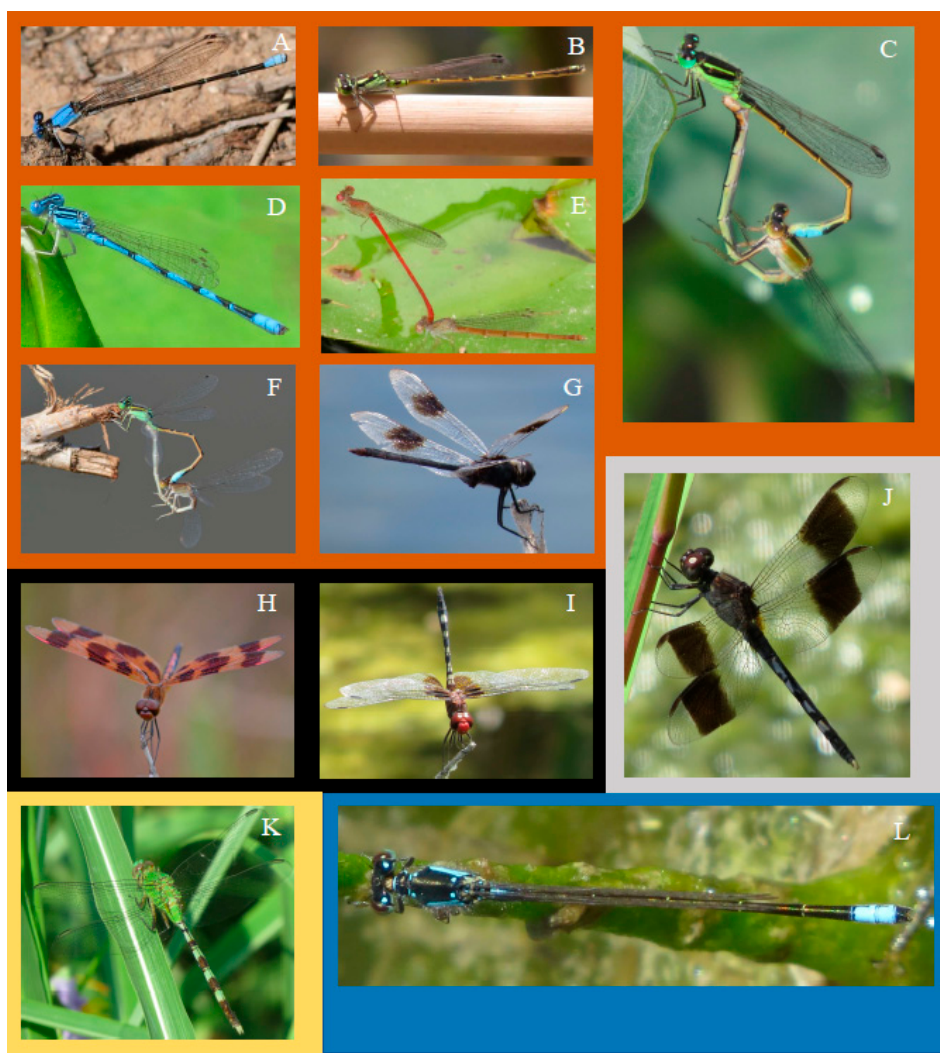
Figure 6. Species that were not found at all three playa wetland types across the Texas panhandle (United States), 2003–2020. Orange: urban playa species (( A ) Argia apicalis , ( B ) Ischnura posita , ( C ) Ischnura ramburii , ( D ) Enallagma basidens , ( E ) Telebasis salva , ( F ) Ischnura barberi , ( G ) Brachymesia gravida ). Black: cropland playa species (( H ) Celithemis eponina , ( I ) Dythemis fugax . Gray: grassland playa species (( J ) Erythrodiplax umbrata ). Yellow: urban and grassland playa species (( K ) Erythemis vesiculosa ). Blue: cropland and urban playa species (( L ) Ischnura damula ). Photographs by N.E. McIntyre.